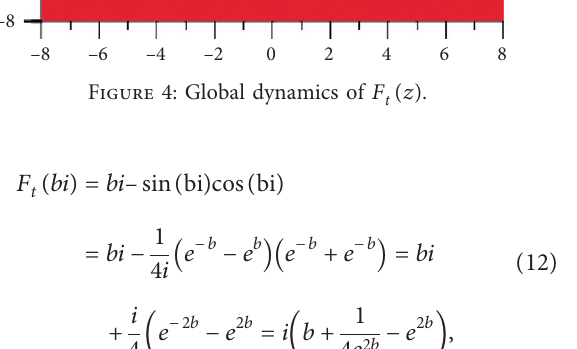
Figure 4: Global dynamics of F